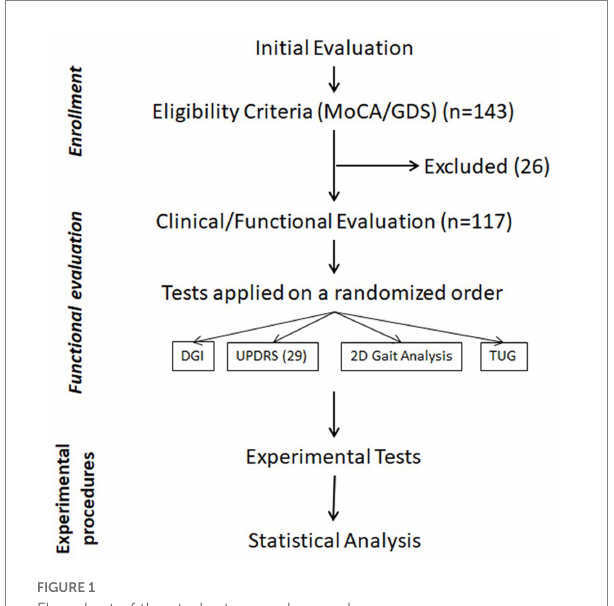
FIGURE 1 Flowchart of the study steps and